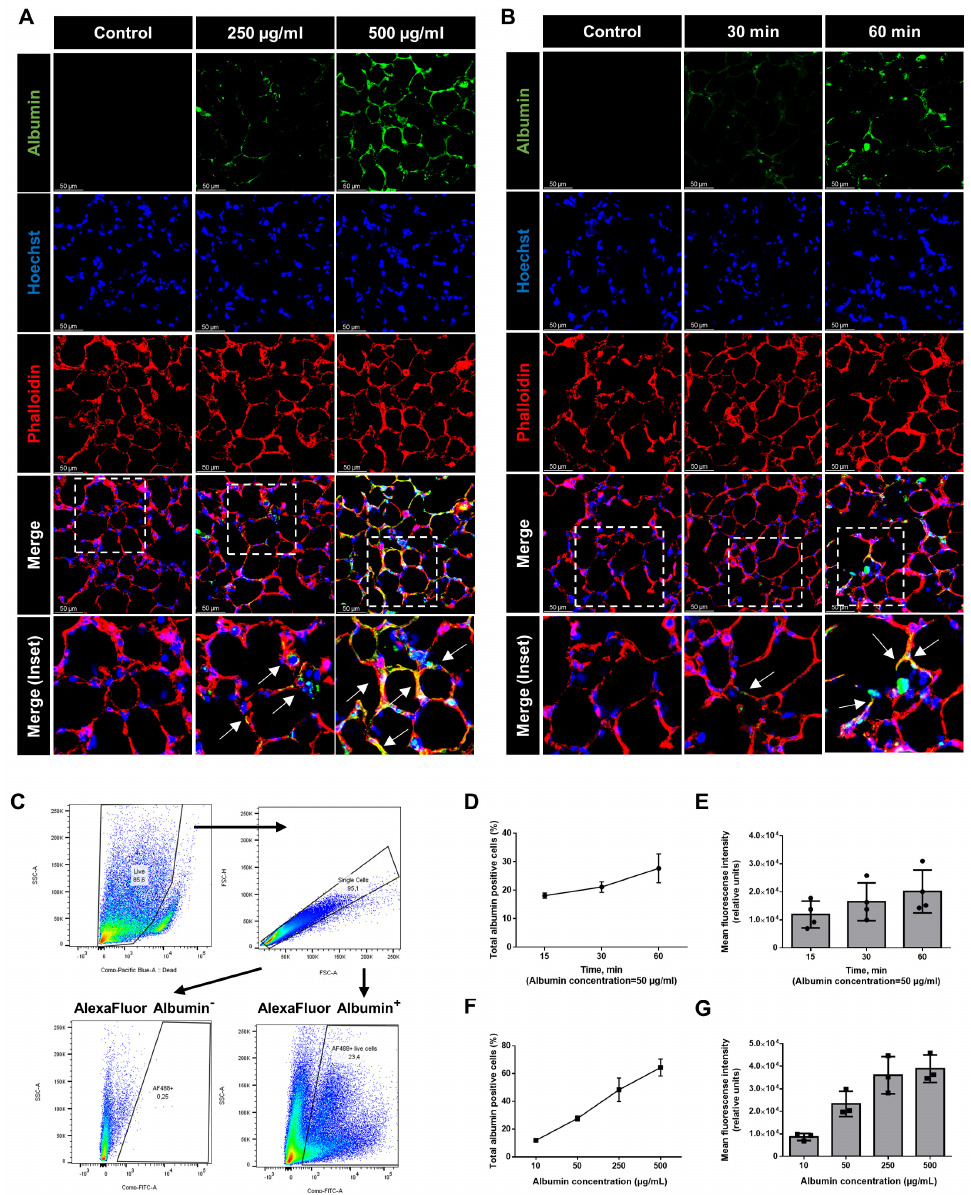
Figure 2. Concentration- and time-dependent uptake of albumin in PCLS: ( A , B ) PCLS were treated with different concentrations for up to 60 min with AlexaFluor488-albumin (green), fixed, stained with Hoechst (blue), and against phalloidin (red), and then analyzed by confocal microscopy. Rep- resentative fluorescent microscopic images are shown. The dashed line boxes mark the insets. The arrows show the co-localization of albumin and phalloidin. Scale bar − 50 µ M ( C ) Dot plots showing the gating strategy for isolation of albumin-positive cells. The different colors in dot plots represent the density of the fluorescent signal ( D – G ) Percentage and mean fluorescence intensity of albumin- positive cells isolated from PCLS at the above-mentioned concentrations and time-point. All graphs show mean ± SD ( n =